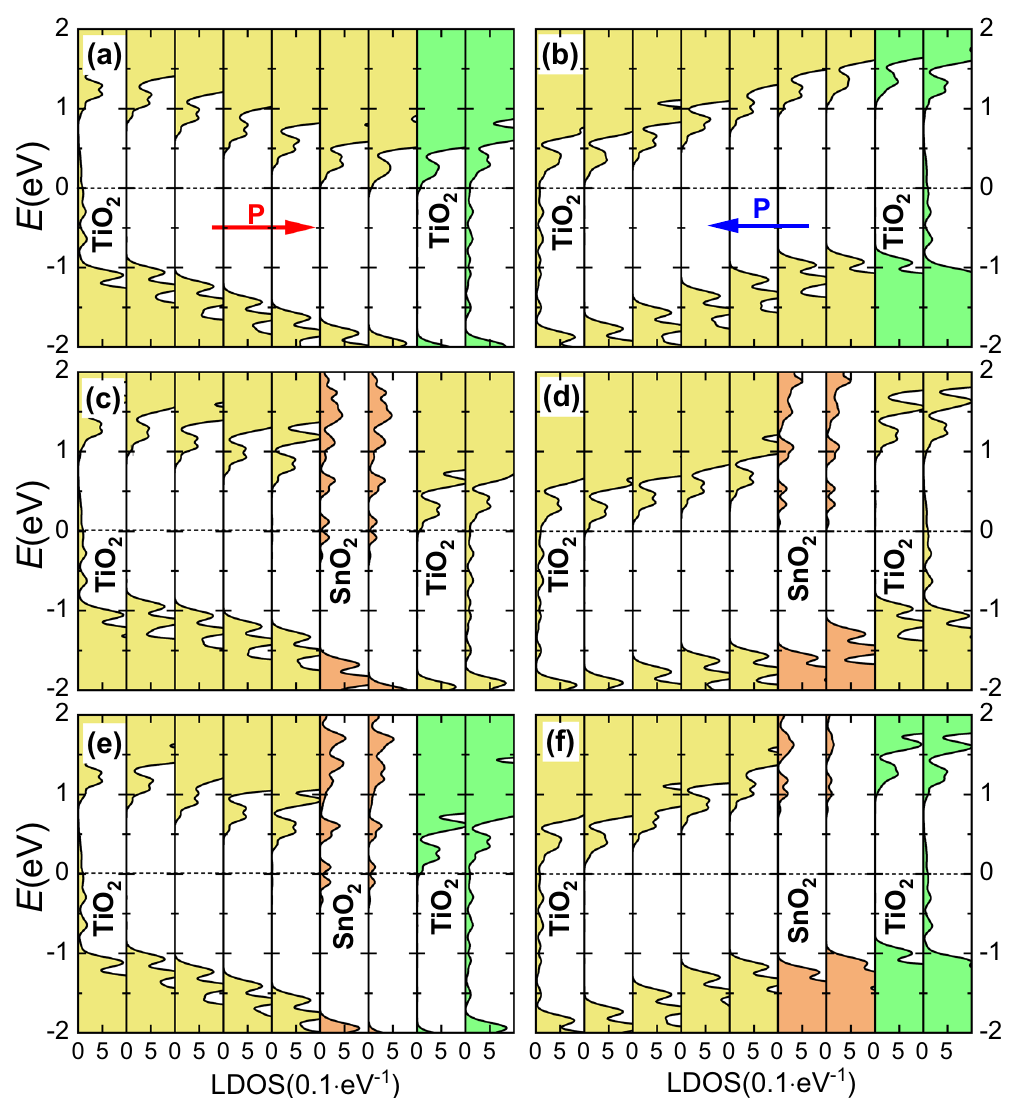
Fig. 2 Local densities of states (LDOS) as a function of energy E on each BO2 (B = Ti, Sn) atomic layer. a , b FTJ-1, c , d FTJ-2, and e , f FTJ-3 with the opposite polarization directions. Arrows indicate the directions of the